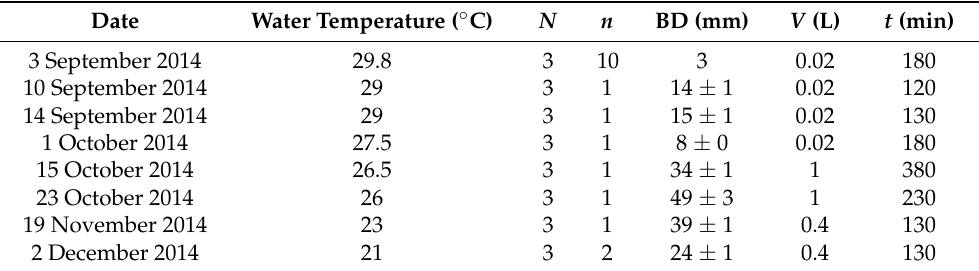
Table 1. Respiration experimental design. N = number of respiration chambers, n = number of medusae in each respiration chamber, V = volume of each respiration chamber, t = duration of respiration measurement. BD = bell diameter ± standard